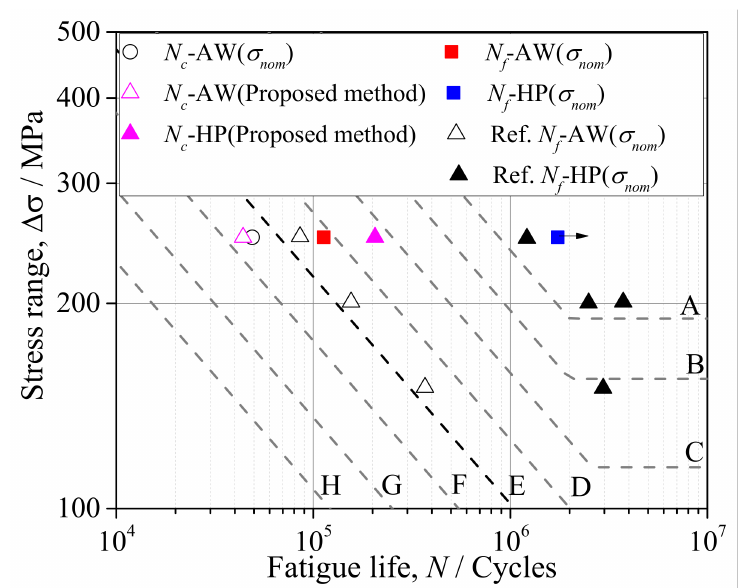
Figure 8. Fatigue life assessed by the proposed